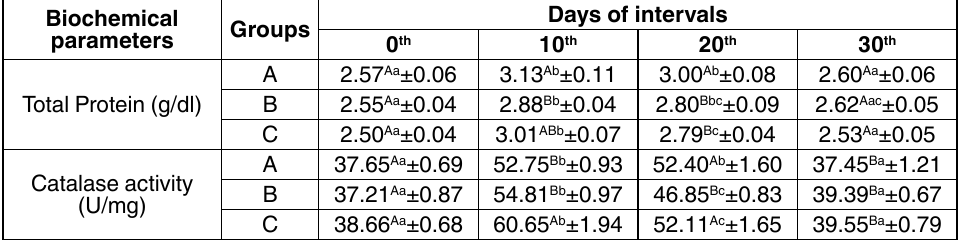
Days of intervals